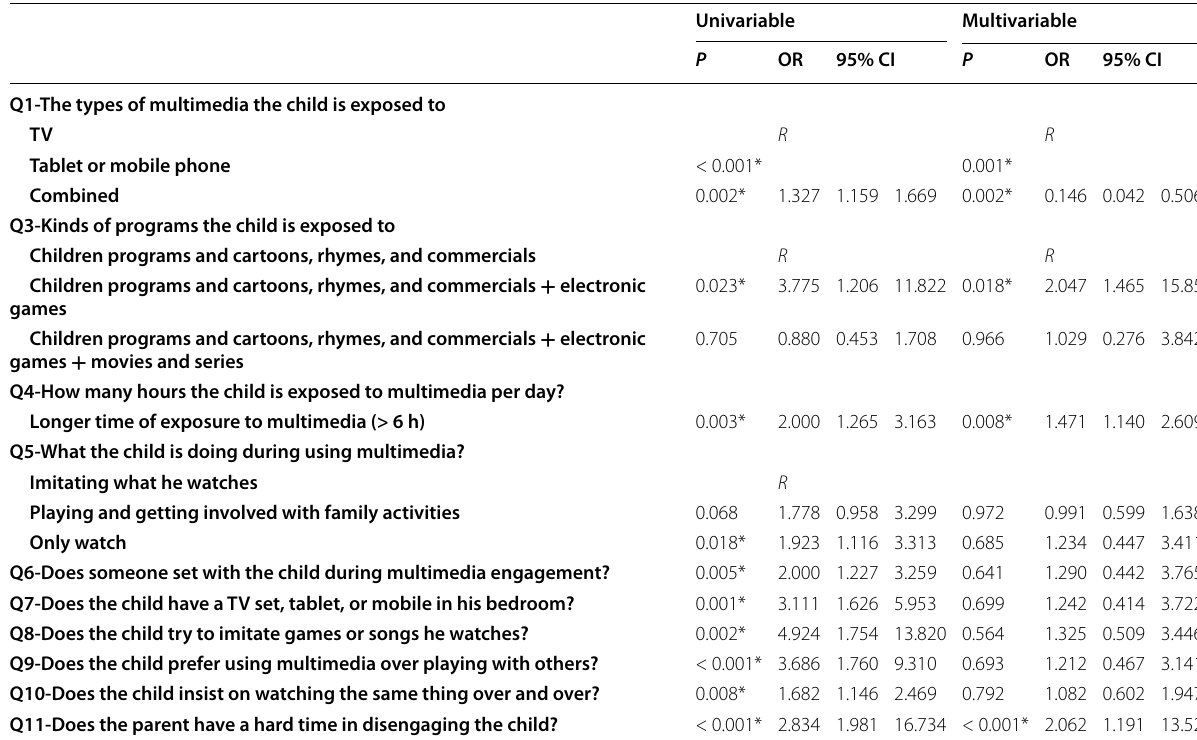
Table 8 Regression analysis for prediction of